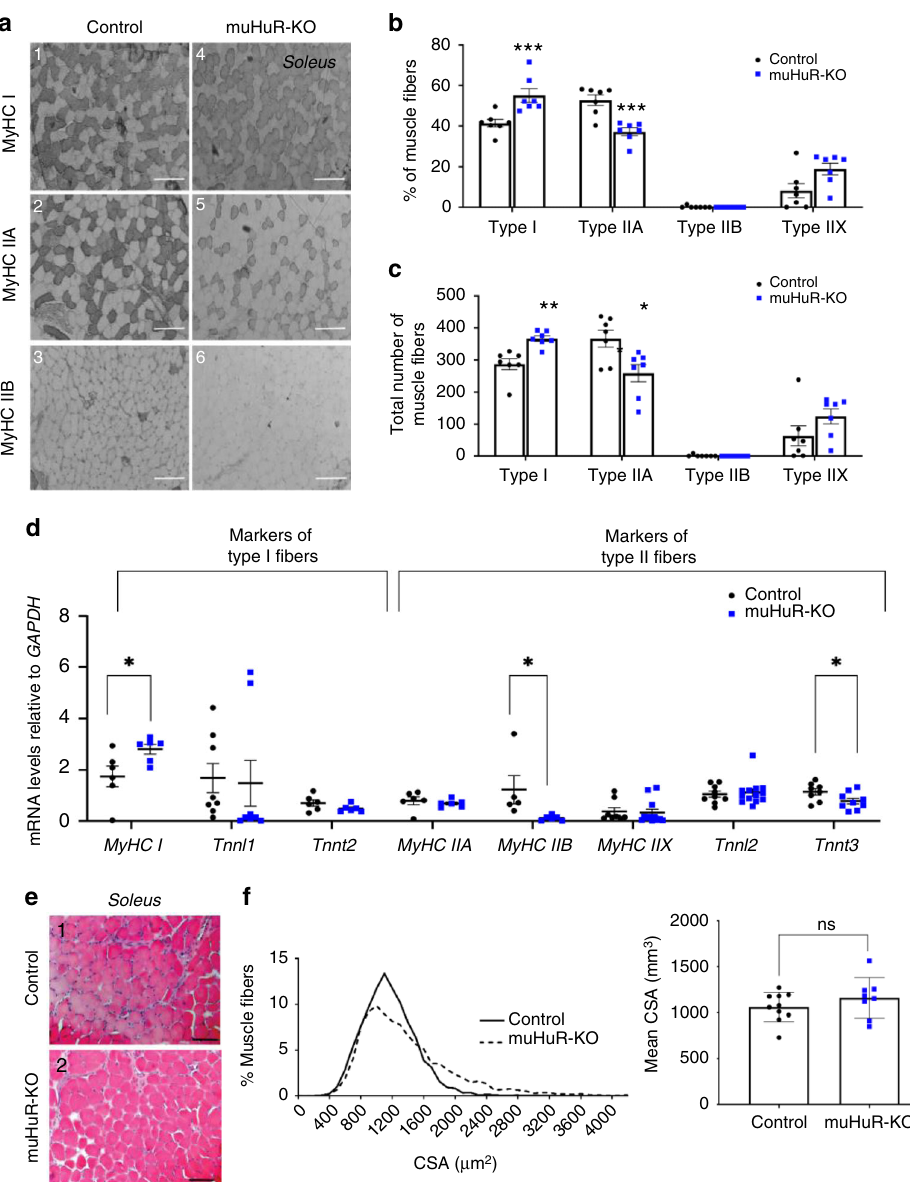
Fig. 4 Depletion of HuR in skeletal muscle increases the proportion of type I fi bers. a Representative photomicrographs of serial sections of soleus muscles from control and muHuR-KO mice taken after immunostaining with anti-Myosin Heavy Chain (MyHC) antibodies type I, type IIA, and type IIB. Scale bars: 100 μ m. Photomicrographs are representative of sections prepared from seven different mice. b Quanti fi cation of muscle fi bers type I, type IIA, and type IIB was ascertained manually. Fibers type IIX were calculated by counting the unstained fi bers. Results are graphed as a percentage of the total number of fi bers per muscle. c Total number of fi bers per muscle is shown for the muscles analyzed in b . n = 7 mice for b , c . d mRNA expression of known markers of fi ber-type speci fi city, MyHC I, Tnnt2, and MyHC IIA (n = 6 mice), TnnI1 (n = 8 mice), MyHC IIB (Control n = 5, muHuR-KO n = 6 mice), MyHC IIX (Control n = 8, muHuR-KO n = 12 mice), TnnI2 (Control n = 9, muHuR-KO n = 13 mice), and Tnnt3 (Control n = 8, muHuR-KO n = 9 mice) was assessed by RT-qPCR. mRNA levels were standardized against GAPDH and plotted relative to the expression in control mice. e Representative photomicrographs of soleus muscles sections from control and muHuR-KO mice taken after H&E staining. Scale bars: 100 μ m ( n = 8 mice). f Left panel: mean CSA of soleus muscles fi bers from control and muHuR-KO mice were analyzed from sections stained with H&E. Right panel: frequency histogram showing the distribution of muscle fi ber CSA in the soleus muscles from control and muHuR-KO mice. (control: n = 10, muHuR-KO: n = 8). Results are presented as mean ± S.E.M, * p < 0.05, ** p